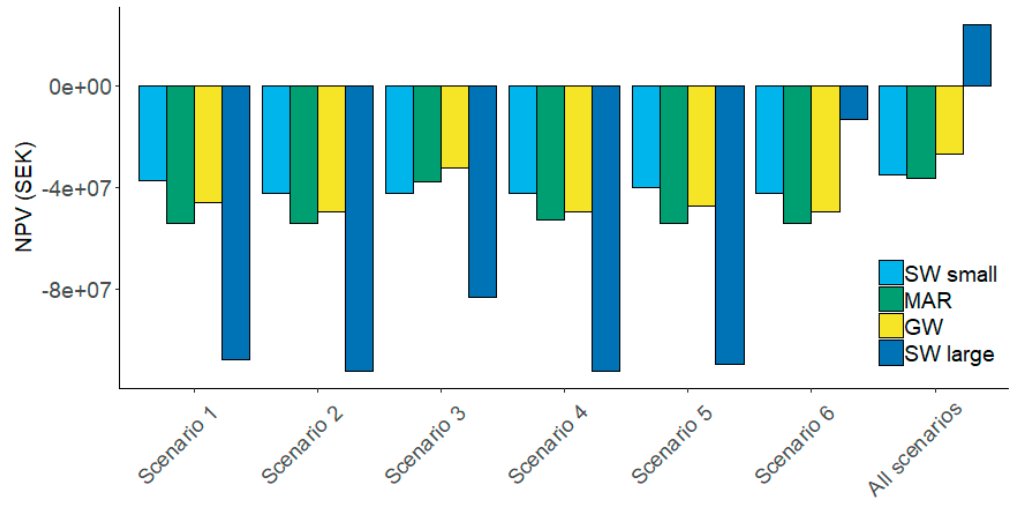
Figure 5. Net present values for measure implementation with the annual benefit of risk reduction for each individual risk scenario and for all scenarios combined, over a 50-year time horizon and with 3.5% discount rate (mean values).